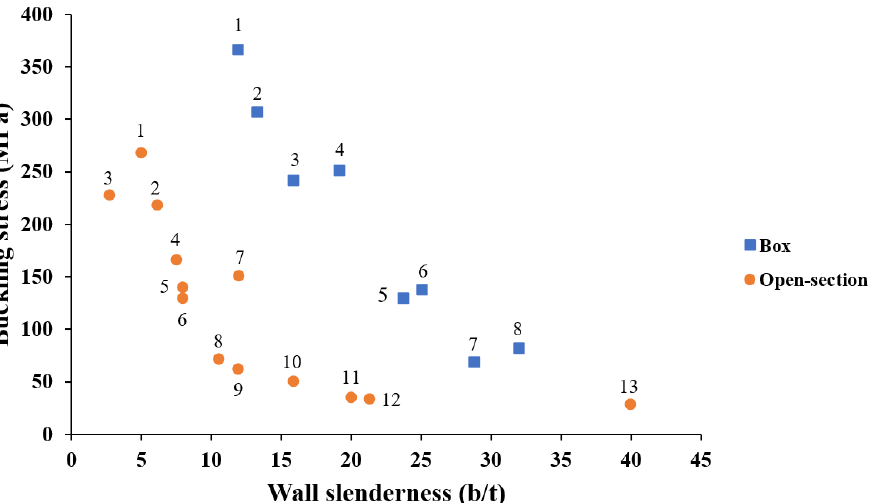
Figure 9. The studied range of wall slenderness for open-section versus box GFRP profiles (Box-shape: